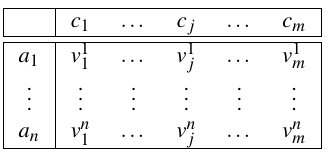
Table 1. Data for a CBRS